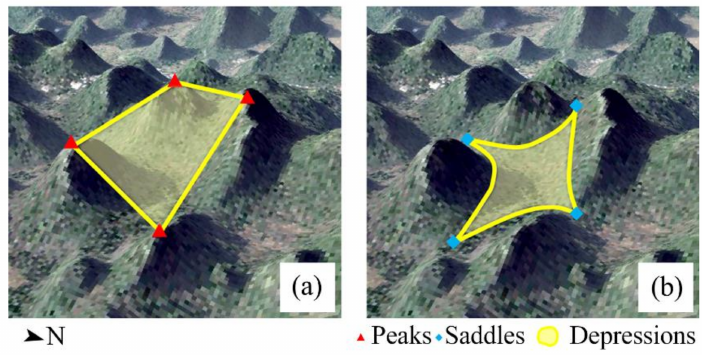
Figure 1. Two views regarding extent of depressions in Fengcong areas: ( a ) the entire range surrounded by peaks and ( b ) the concave part under the